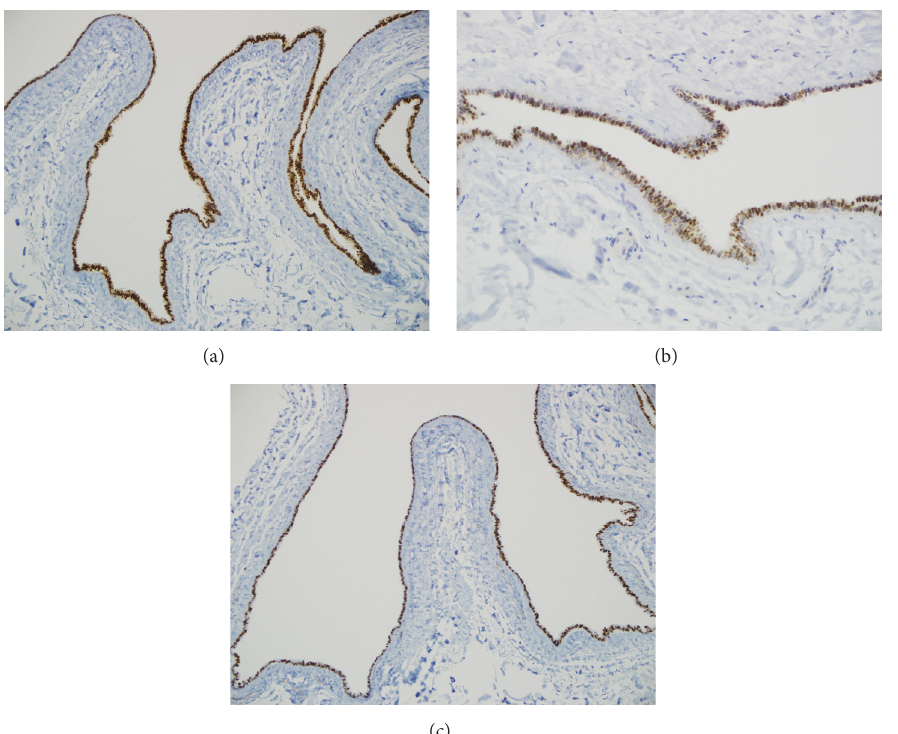
Figure 3: The immunohistochemical staining profile supports the notion of a Mullerian origin. Progesterone receptor immunostain shows strong and diffuse positivity in the cyst lining epithelium ((a) magnification, 100x) and PAX-8 is positive in the majority of the epithelial lining cells ((b) magnification, 200x). The lining is strongly and diffusely positive for WT1 immunostain which is localized to the nuclei ((c) magnification,